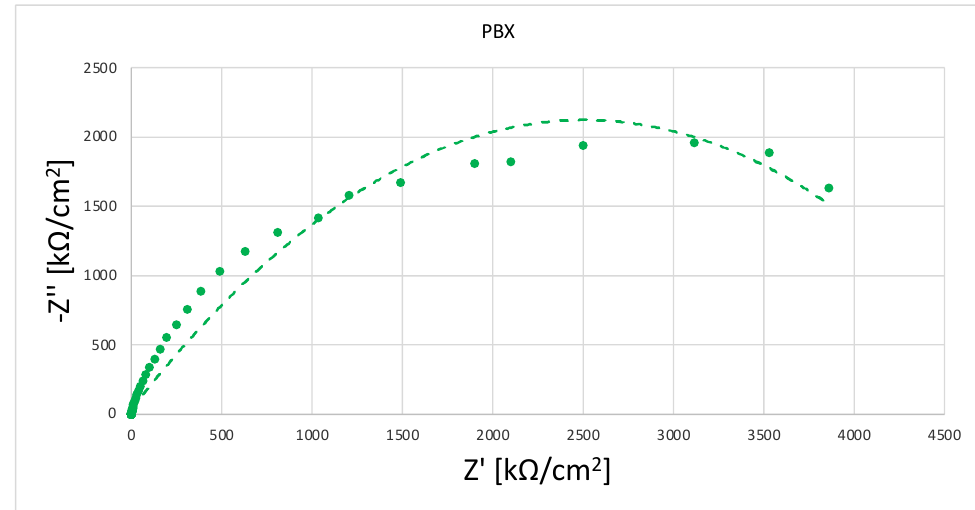
Figure 11. Nyquist plot for a sample strengthened with PBX material .